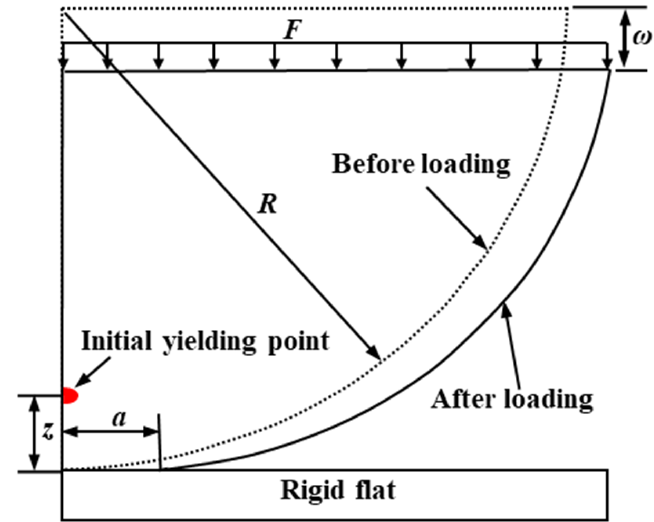
Figure 1. A flattening model before (dashed line) and after (solid line) loading.